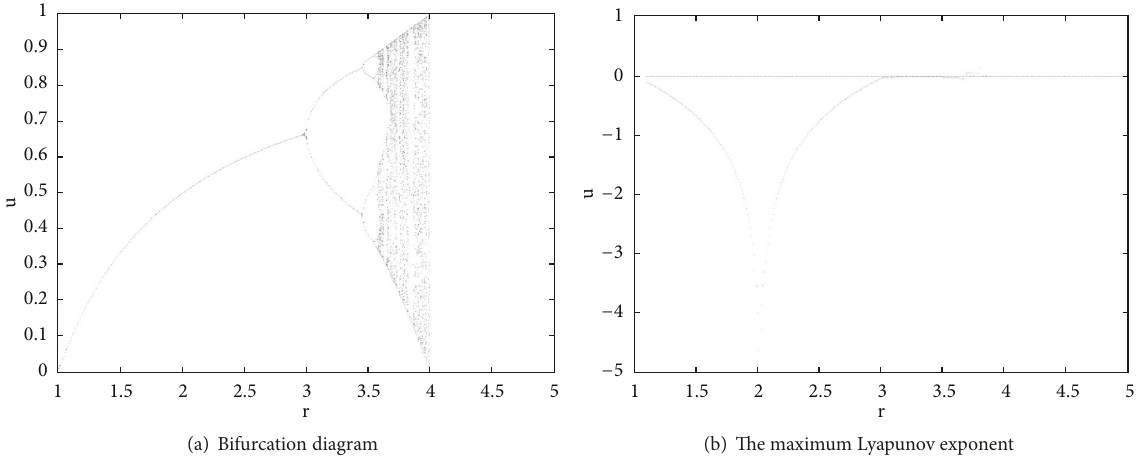
Figure 1: Flip bifurcation diagram of model (7) with 𝑟 ∈ [1.1;5] ; maximum Lyapunov exponents corresponding to flip bifurcation diagram.